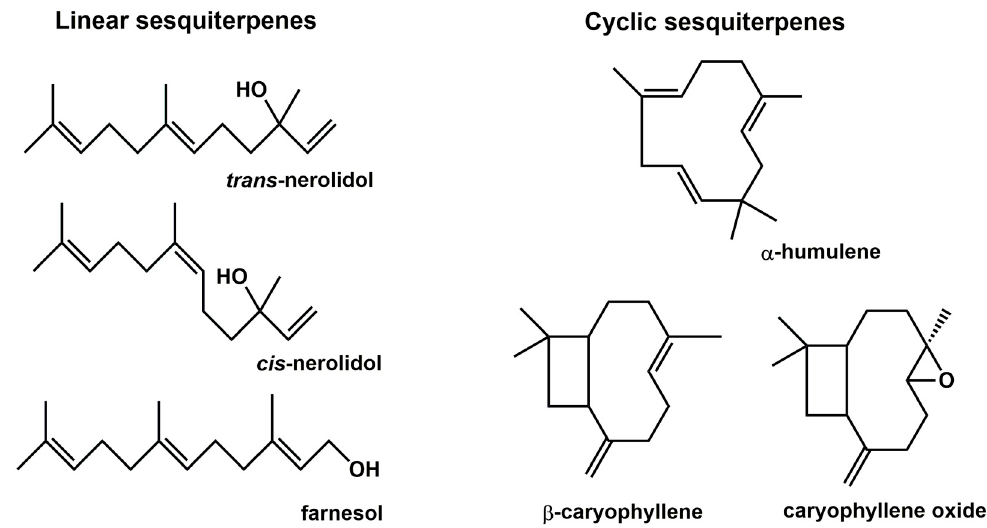
Figure 1. Chemical structures of the studied sesquiterpenes.